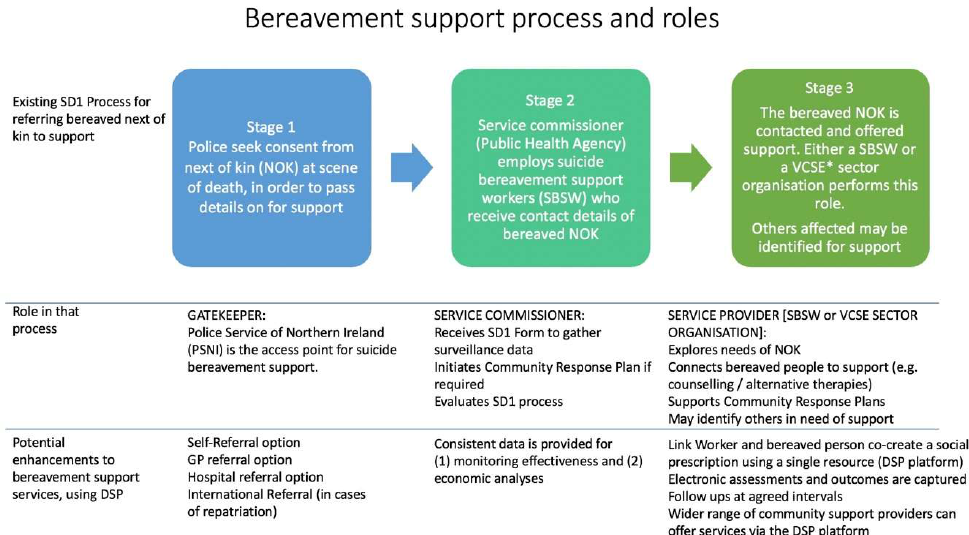
Figure 2. Representation of workshop discussion (Part 2) focused on client pathways and support roles, including the potential of digital social prescribing (DSP). * VCSE Voluntary Community and Social Enterprise